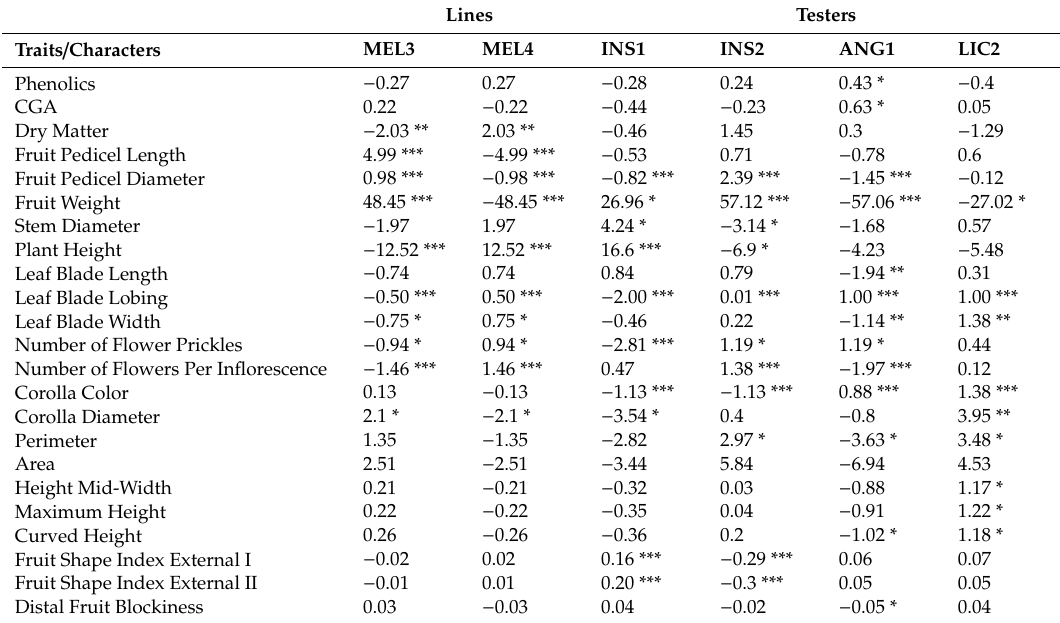
Table 5. Estimates of the general combining ability (GCA) e ff ect for the descriptors studied. Lines